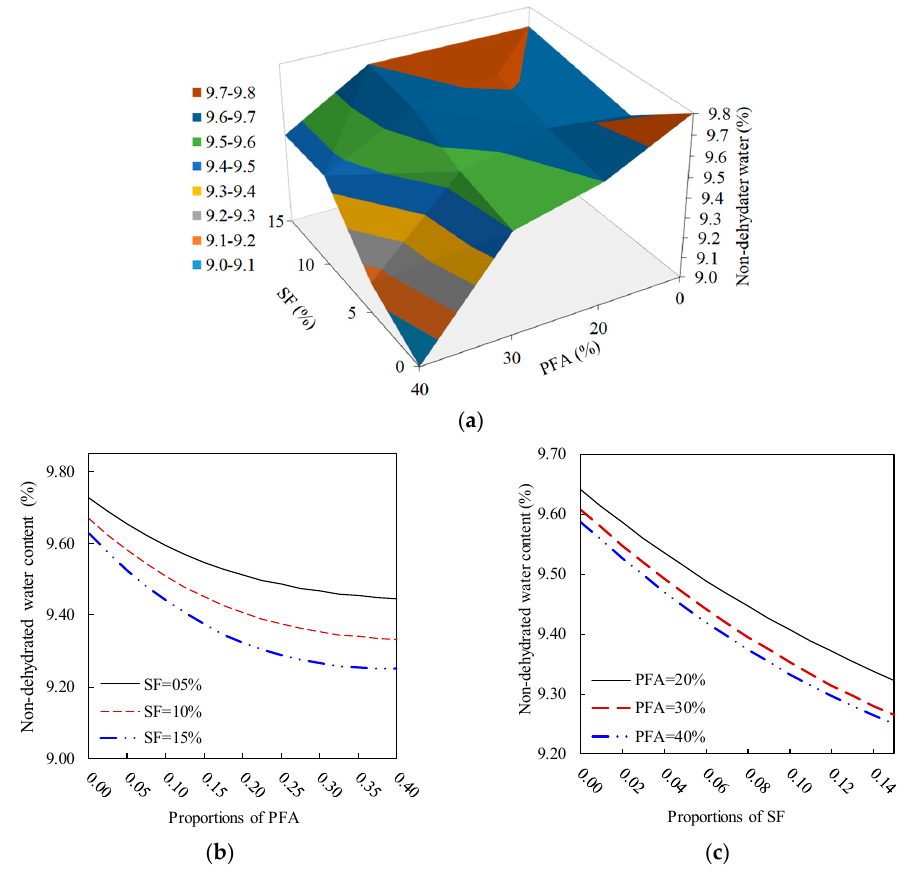
Figure 12. Effect of the PFA and SF on the 28-day non-dehydrated water content of ternary blended systems: ( a ) response surface, ( b ) constant SF, ( c ) constant PFA.